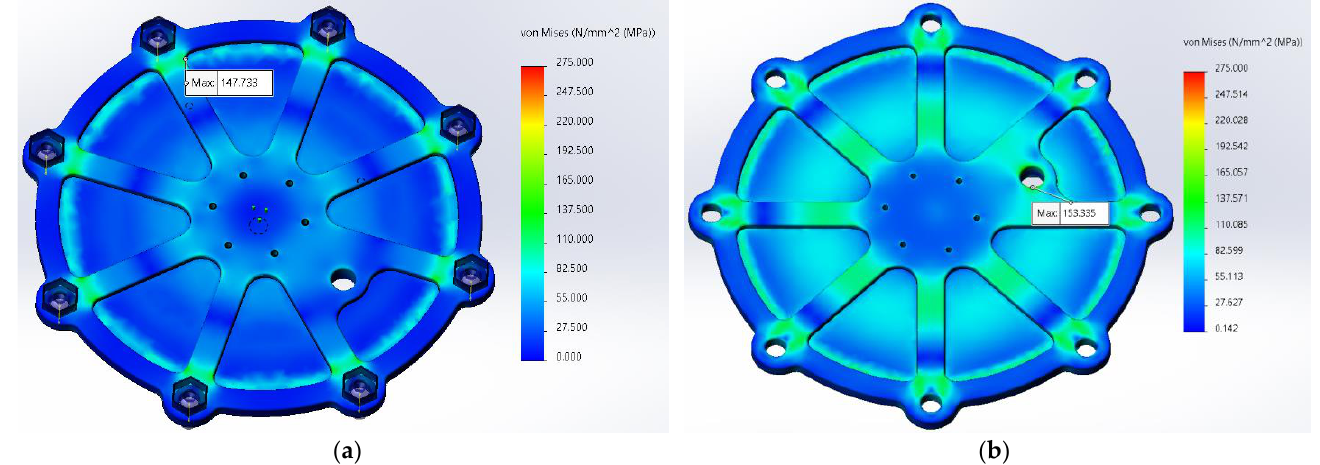
Figure 10. Von Mises equivalent stresses for the lid structural validation: 24 V ( a ) and 48 V assem- blies ( b ).